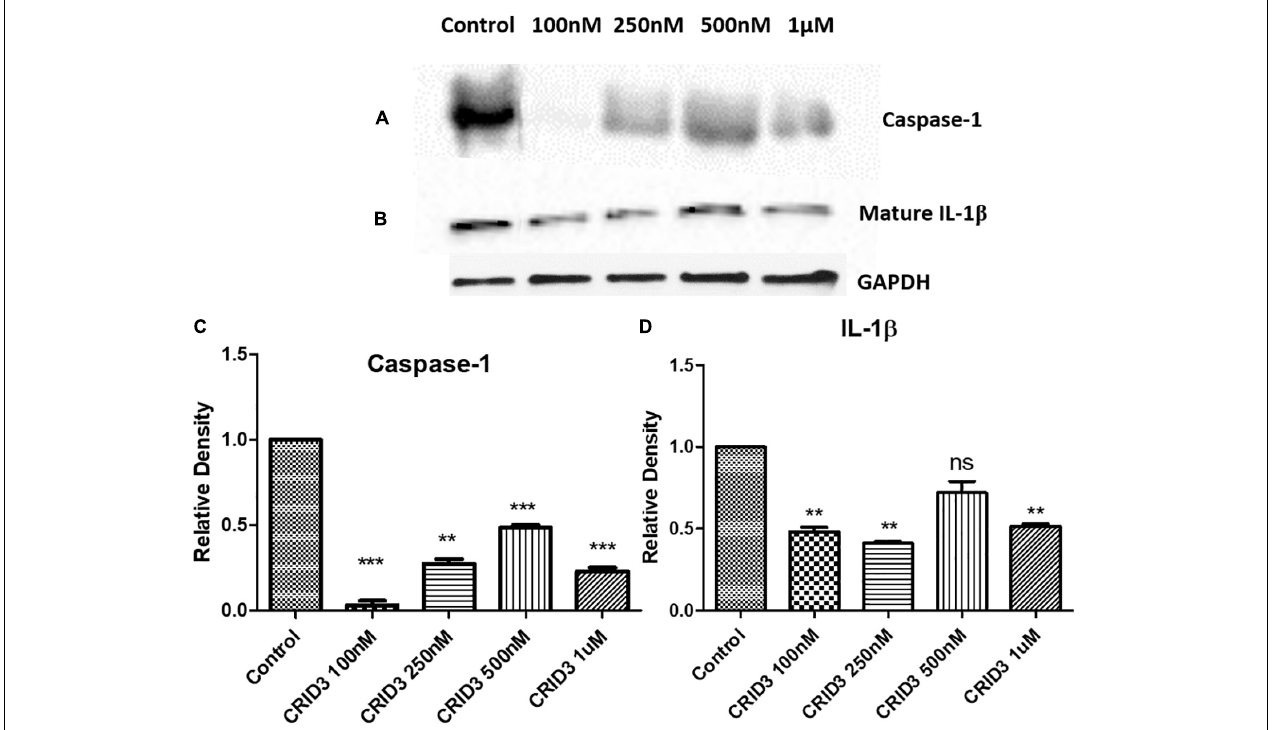
FIGURE 3 | Cytokine release inhibitory drug (CRID3) inhibits Caspase-1 and IL-1 β protein expression. SH-APP cells were co-cultured with CHME5 microglia cell line (microglia: neuron ratio of 1:2) in the presence of CRID3 (25–100 nM) for 48 h. Cells were harvested and the cell pellet was used in western blot for Caspase-1 (A) and IL-1 β (B) protein expression analysis. Relative protein expression was calculated using ImageJ and a significant inhibition was observed for Caspase-1 (C) and IL-1 β (D) protein expression at 100 nM CRID3 concentration compared to the water-treated control cells ( n = 3) ( ∗∗ p ≤ 0.01; ∗∗∗ p ≤ 0.001).